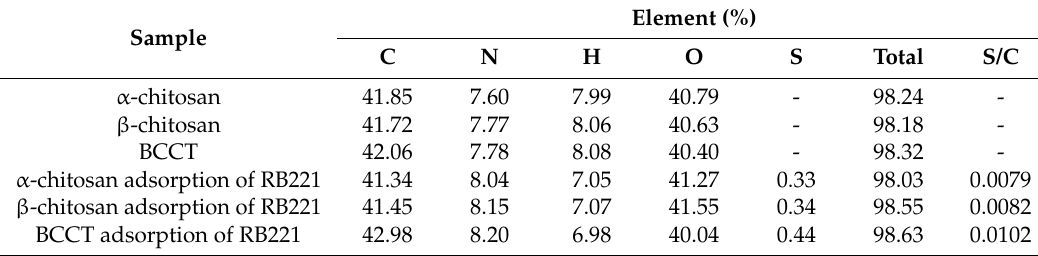
Table 5. Elemental analyses on the adsorbents before and after their adsorption of the RB221